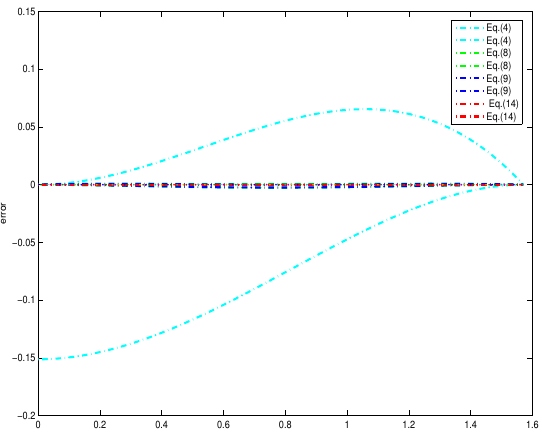
Figure 3. Error plots between sinc(x) and the polynomial bounds of degrees 3 and 5.